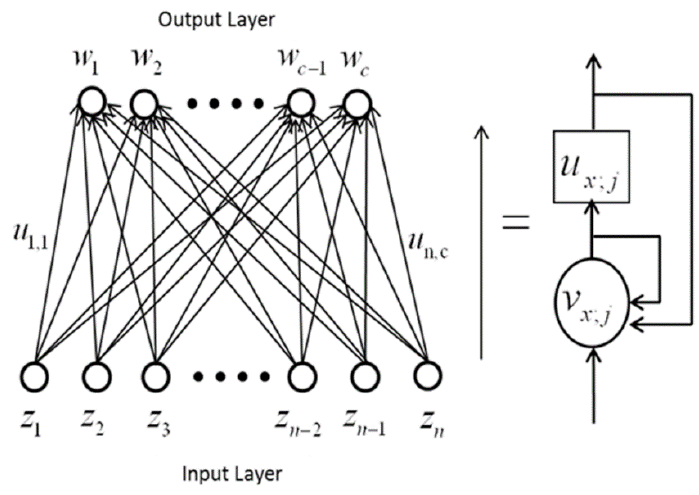
Figure 5. The annealed chaotic neural network